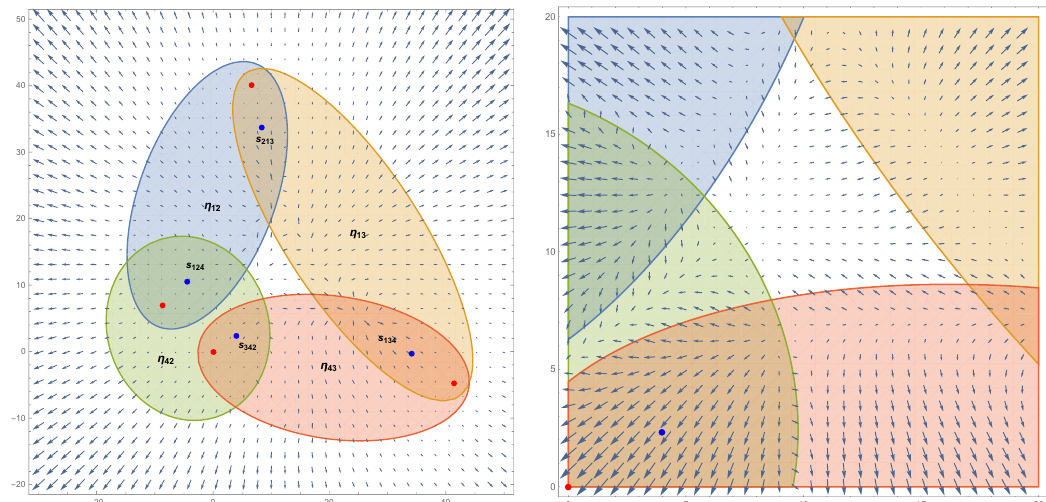
Figure 5. A correct deformation direction with functional form described by eq. (3.16) for Box4E using four sources which are excluded on those E-surfaces whose interior does not contain the source. The right plot is a zoom-in on the central